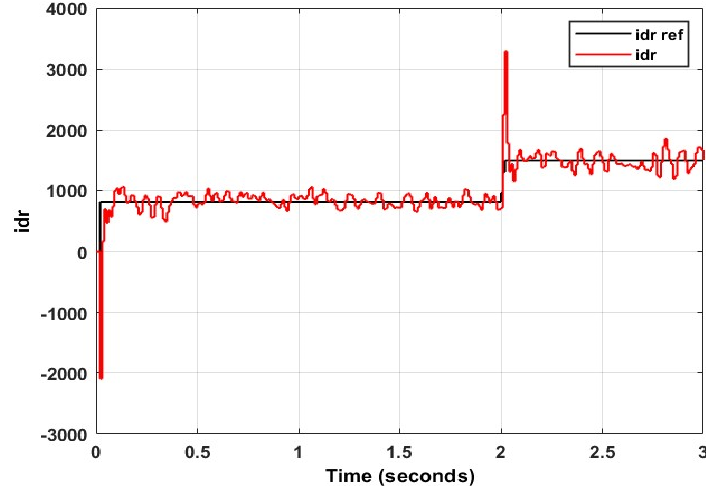
Figure 51. Rotor direct axis current ripple using DCI at 90% dip.